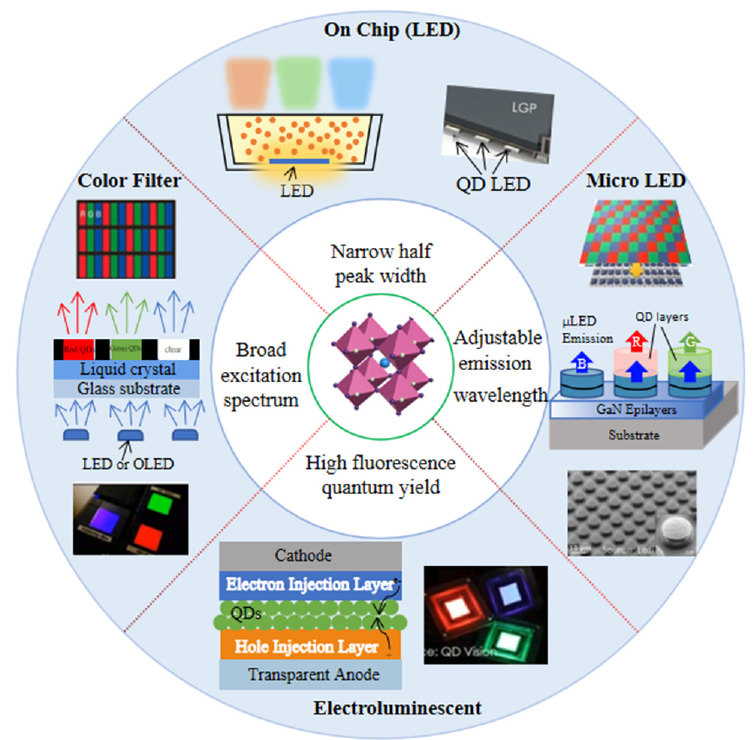
Figure 2. Schematic diagram of the research direction of PQD displays.